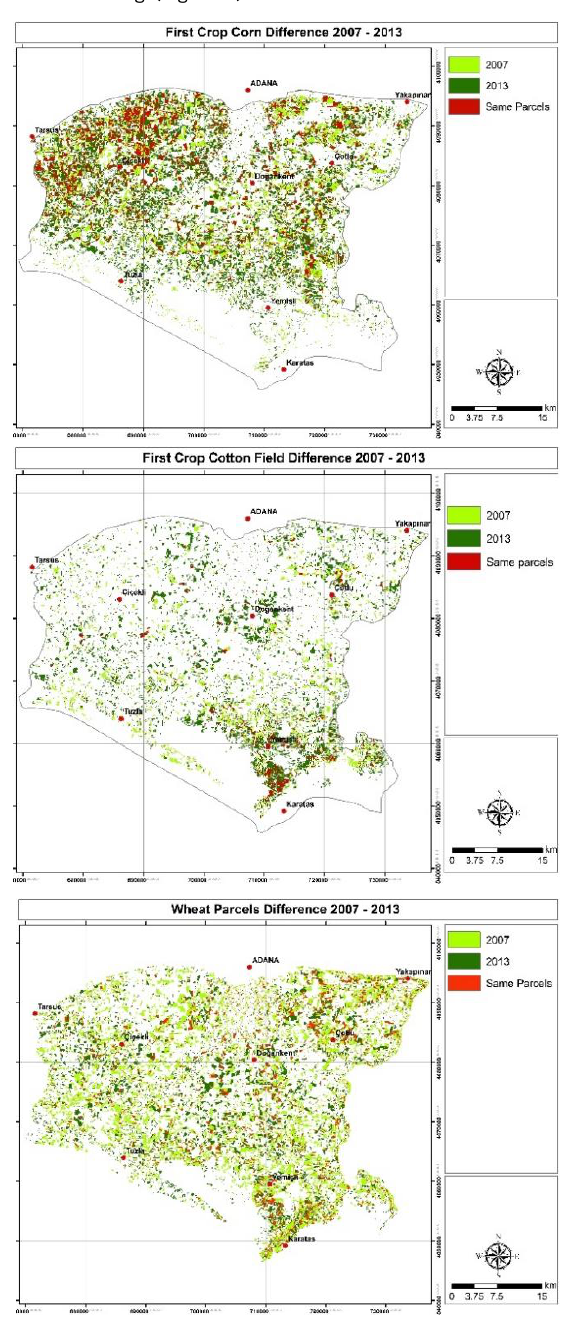
Figure 6. Areal movements of the wheat, corn and cotton production areas in 7